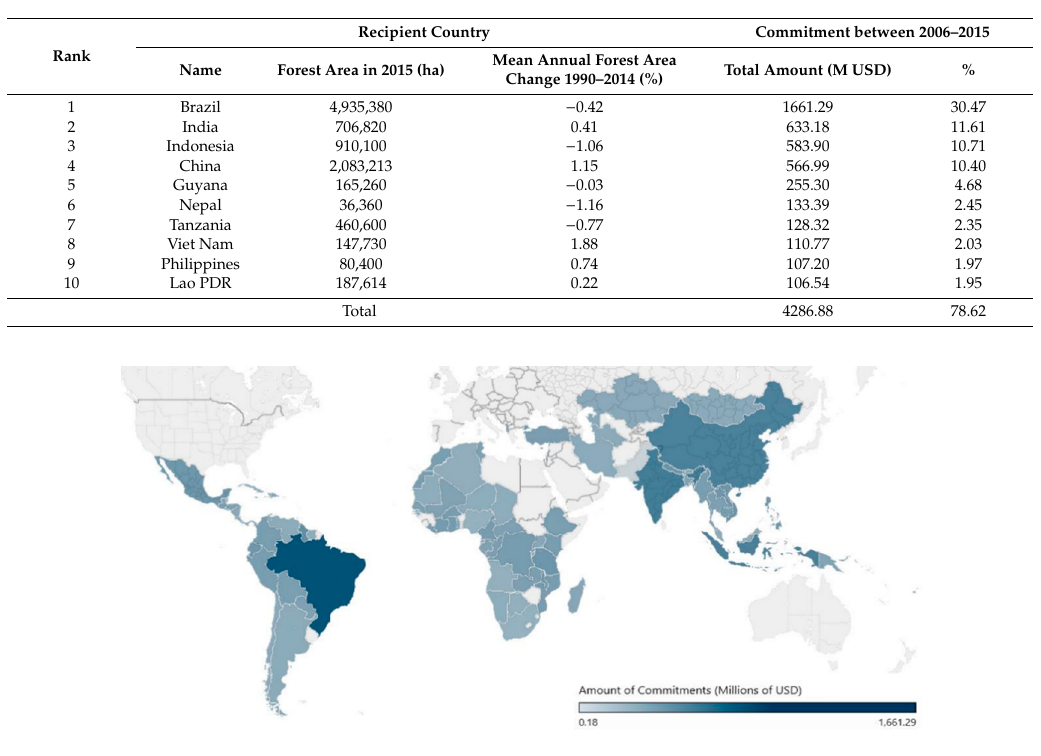
Figure 2. Amount of Commitment allocated to Recipient countries of Bilateral REDD+ projects between 2006–2015.